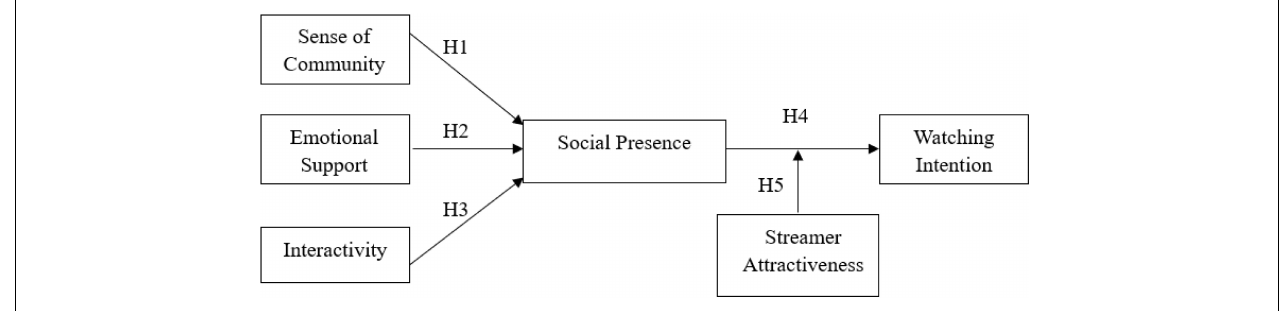
FIGURE 1 | Conceptual